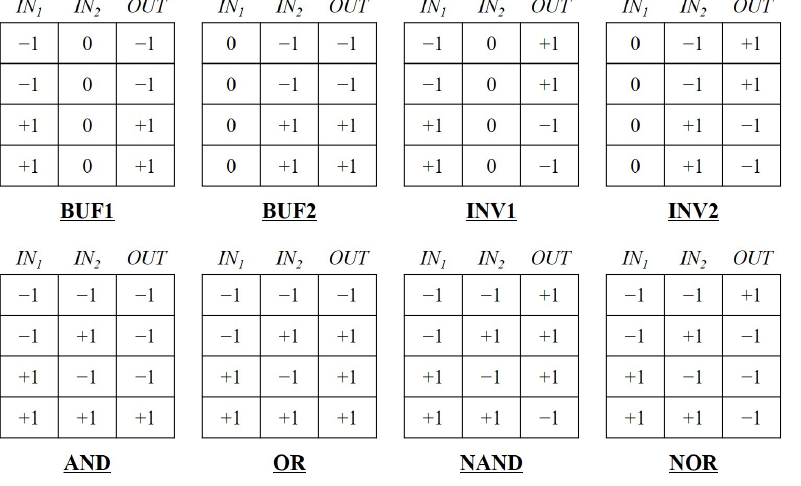
Figure 9. Truth tables for target logic gates. While BUF1 and INV1 are buffer and inverter with an input of IN 1 , BUF2 and INV2 are buffer and inverter with an input of IN 2 . For the agent’s DQN, the numbers of units in f c 1 , f c 2 , and f c 3 are assigned to twice as large as the dimensionality of X ( N x ) that is 138. The size of f c 4 is equal to N s of 126. An (cid:101) -greedy method is adopted with the random action selection probability ( (cid:101) ) of 0.1. The discounting factor, γ , is 0.95 and the network is optimized by Adam with a learning rate of 0.001. In addition, there exist 8 special replay buffers dedicated to target logic gates (S0RB for BUF1, S1RB for BUF2, S2RB for INV1, S3RB for INV2, S4RB for AND, S5RB